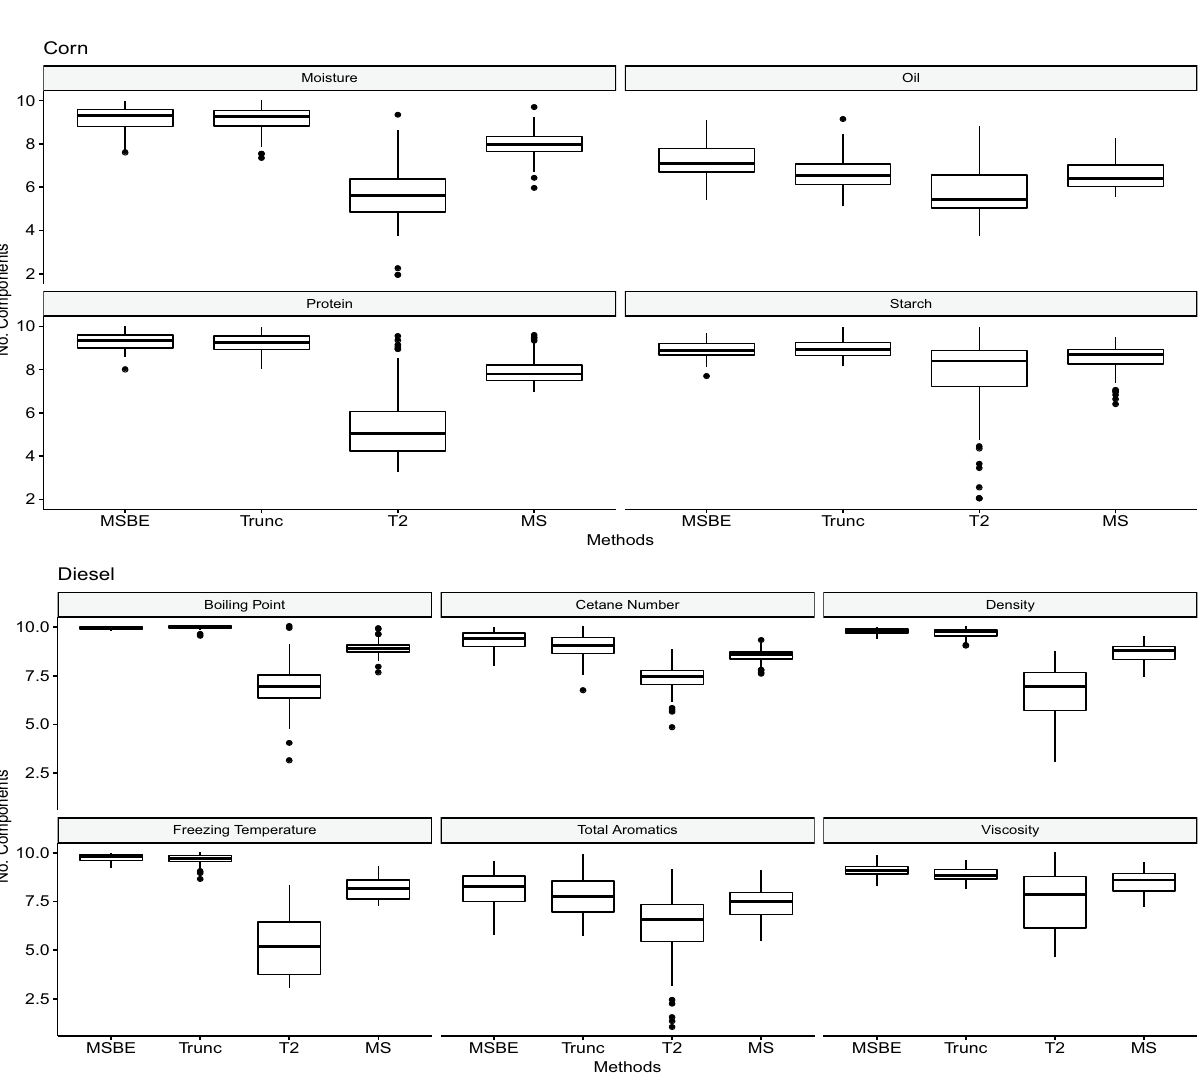
Figure 6. The distribution of number of components presenting the complexity of the model is presented for all fitted corn and diesel contents models. Trends are extracted based on the 100 Monte Carlo simulation. Results indicates, for corn’s moisture MSBE-PLS and Trunc-PLS consumes larger number of PLS components and are considered as complex model. For corn’s oil all methods consumes moderate number of PLS components. For corn’s protein MSBE-PLS and Trunc-PLS consumes larger number of PLS components